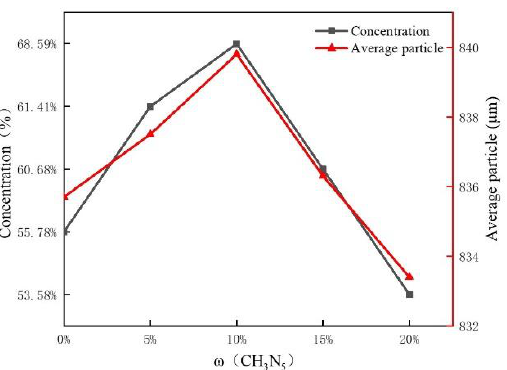
Figure 7. Variation trend of the smoke concentration and average particle size of samples with dif- ferent 5AT mass fractions in the system.